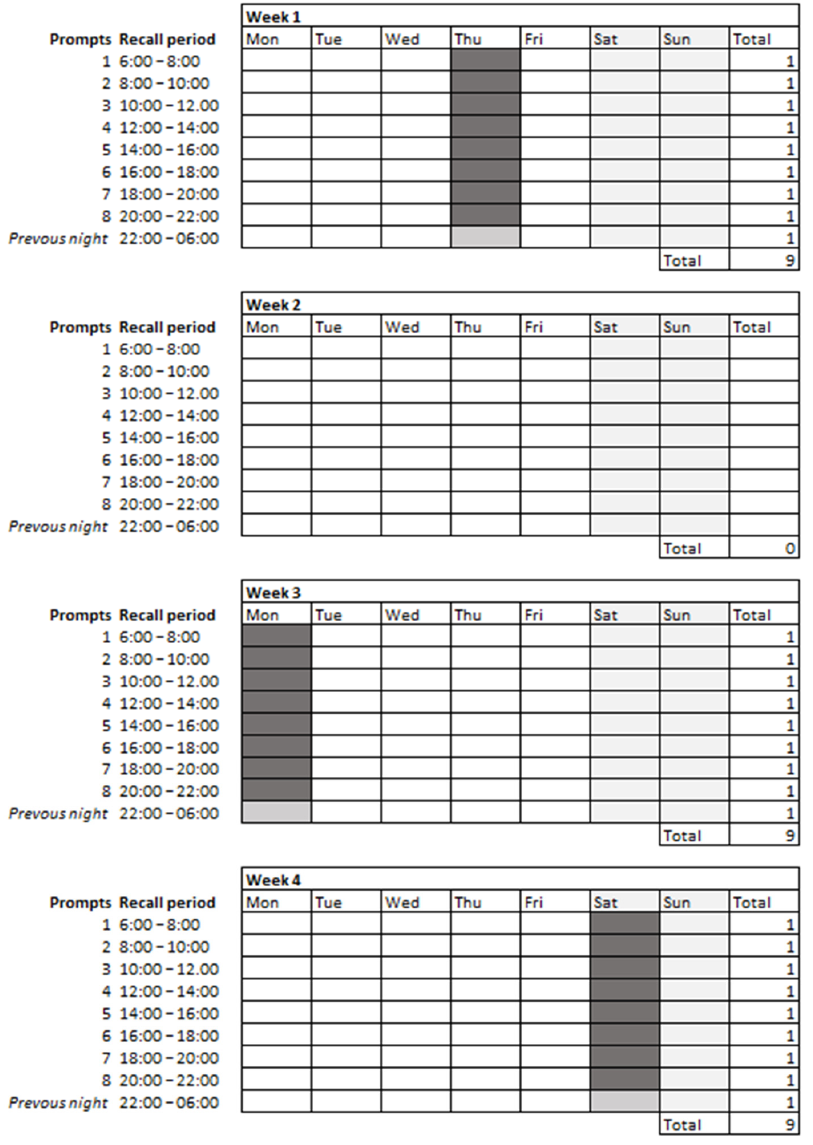
Figure 2. Example actual intake sampling scheme (i.e., three 2hR-days).